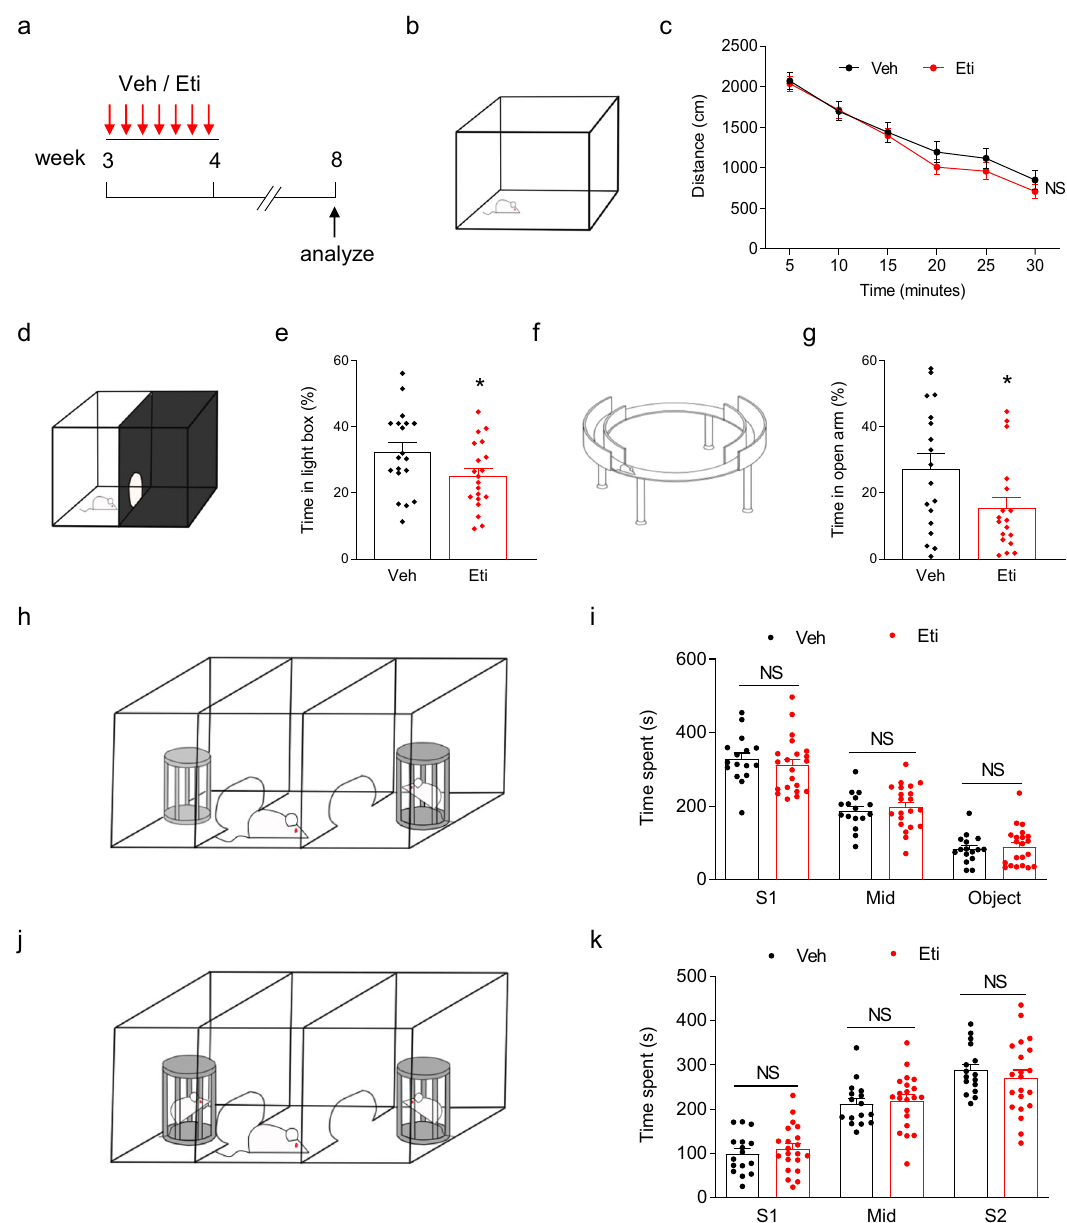
Fig. 9 Elevated anxiety-like behavior after inhibition of DRD2 during adolescence. a Experimental design. WT rats received daily injection of Eti (1 μ g in 0.5 μ l per side) or Veh (0.5 μ l saline per side) into layer 5 of ACC between 3- and 4-week-old age, and behaviors were analyzed at 8-week-old age. b Schematic diagram of open fi eld. c Travel distance in open fi eld was no difference between Eti and Veh-treated rats. NS not signi fi cant, Genotype F (1, 246) = 2.133, P = 0.1454, two-way ANOVA, n = 22 for controls, n = 21 for Eti-treated rats. Data are presented as mean values ± SEM. d Schematic diagram of light-dark box. e Time spent in light box was reduced in Eti-treated rats, compared with controls. * P = 0.046, two-sided t -test, n = 19 for controls, n = 20 for Eti-treated rats. Data are presented as mean values ± SEM. f Schematic diagram of elevated maze. g Time spent in open arm was decreased in Eti-treated rats, compared with controls. * P = 0.0376, two-sided t -test, n = 18 for controls, n = 18 for Eti-treated rats. Data are presented as mean values± SEM. h Schematic diagram of three-chamber test to study social interaction. i Social interaction was normal in Eti-treated rats. Time spent in each chamber was quanti fi ed. NS not signi fi cant, P (S1) = 0.7722, P (Mid) = 0.9379, P (Object) = 0.9806, two-way ANOVA followed by Sidak ’ s multiple comparisons test, n = 16 for controls, n = 21 for Eti-treated rats. Data are presented as mean values± SEM. j Schematic diagram of three-chamber test to study social novelty. k Social novelty was intact in Eti-treated rats. Time spent in each chamber was quanti fi ed. NS not signi fi cant, P (S1) = 0.9369, P (Mid) = 0.9765, P (S2) = 0.7556, two-way ANOVA followed by Sidak ’ s multiple comparisons test, n = 16 for controls, n = 21 for Eti-treated rats. Data are presented as mean values ±